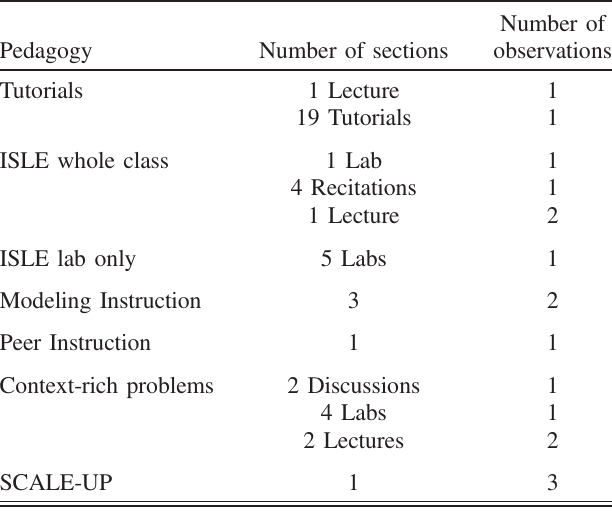
TABLE III. Number of course sections and observations for each pedagogy included in this